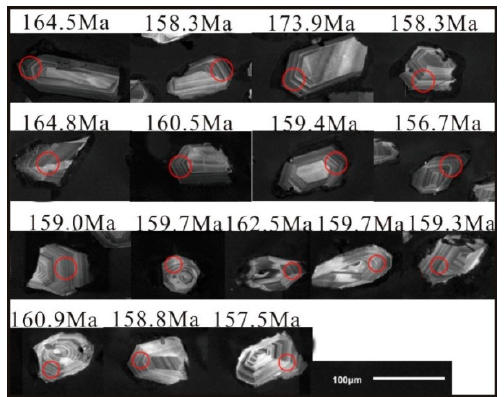
Figure 8. Representative CL images of zircon grains and 206 Pb/ 238 U ages of the Xiajinbao granite. Zircons from different sources can have different Th and U contents. Magmatic zircons typically